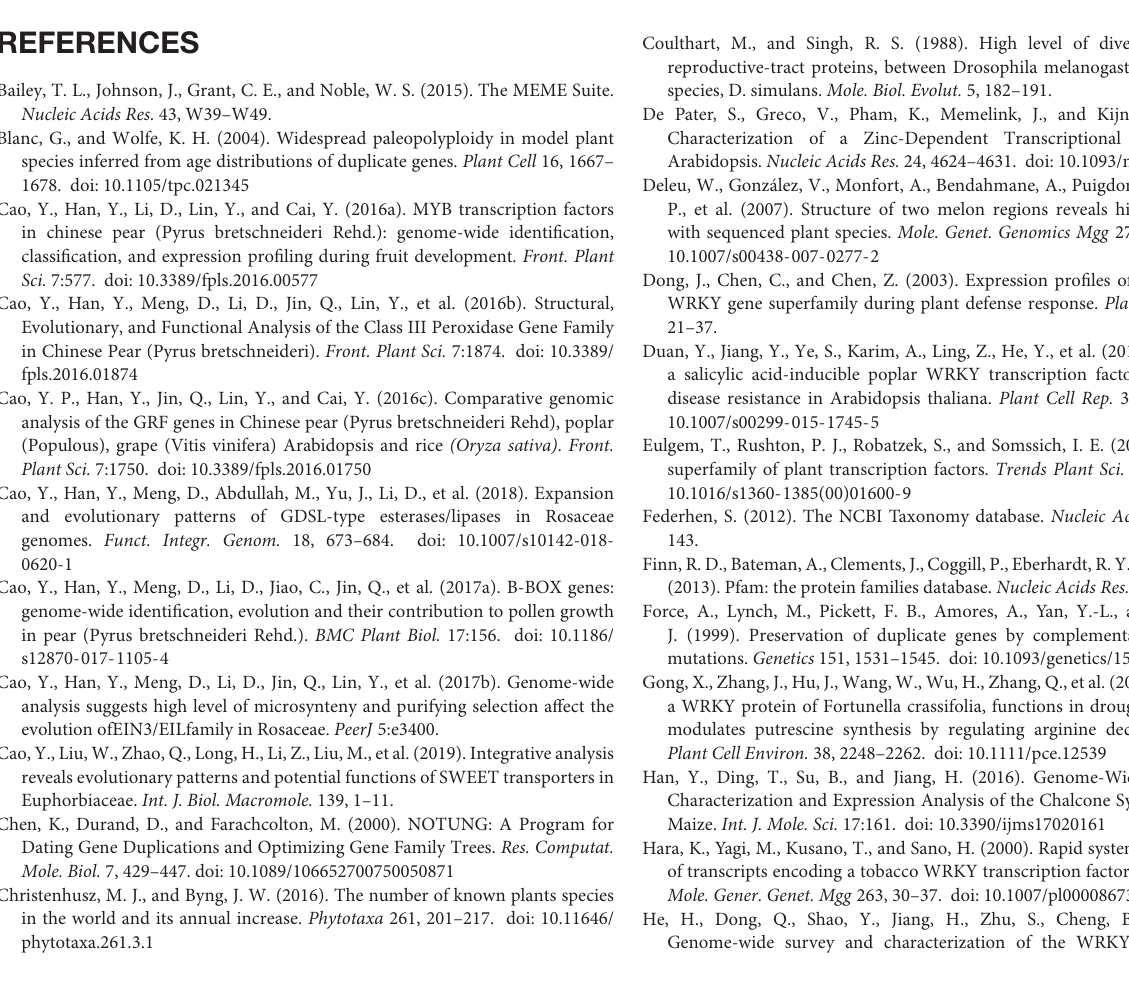
Supplementary Figure 6 | Expression profiles of P. mume WRKY I genes in different tissues. Blue and red colors correspond to down-regulation and up-regulation, respectively. Supplementary Figure 7 | Expression profiles of R. occidentalis WRKY I genes in different tissues. Blue and red colors correspond to downregulation and upregulation, respectively. Supplementary Figure 8 | Expression profiles of M. domestica WRKY I genes in different tissues. Blue and red colors correspond to downregulation and upregulation, respectively. Supplementary Figure 9 | Expression profiles of F. vesca WRKY I genes in different tissues. Blue and red colors correspond to downregulation and upregulation, respectively. Supplementary Figure 10 | Expression profiles of P. bretschneideri WRKY I genes in different tissues. Blue and red colors correspond to downregulation and upregulation, respectively. Supplementary Table 1 | Synteny data in P. avium , P. persica , P. mume ,